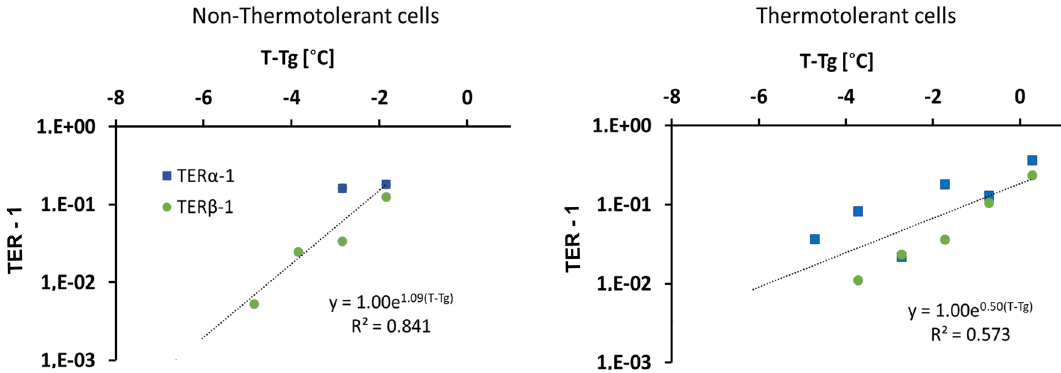
Figure 3. Thermal enhancement ( TER − 1 ) as function of the relative temperature ( T − T g ) for M8013 mouse mammary carcinoma cells in vitro 59 . ( a ) Thermotolerant modification of the cell line and ( b ) Non- thermotolerant cells. Vertical axes displayed in logarithmic scale. The lines are exponential fittings of the TER α − 1 and TER β − 1 points together.